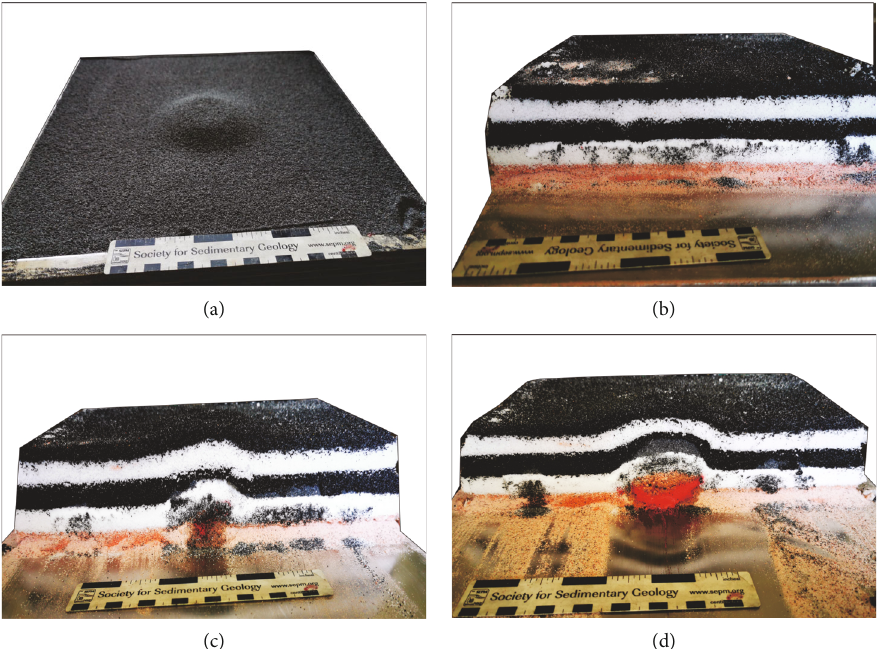
Figure 4: Experiment 1-1 records the formation simulation of mud diapir under overpressure. (a) After fl uid injection, the model surface forms a mound like uplift; (b) the side view of the model; (c) the crosscutting diagram of the model outer edge, which shows that under the action of fl uid arching, the stratum appears to be upward bending; (d) the crosscutting diagram of the model center, which shows that the stratum is faulted and pulled upward under the action of diapir.